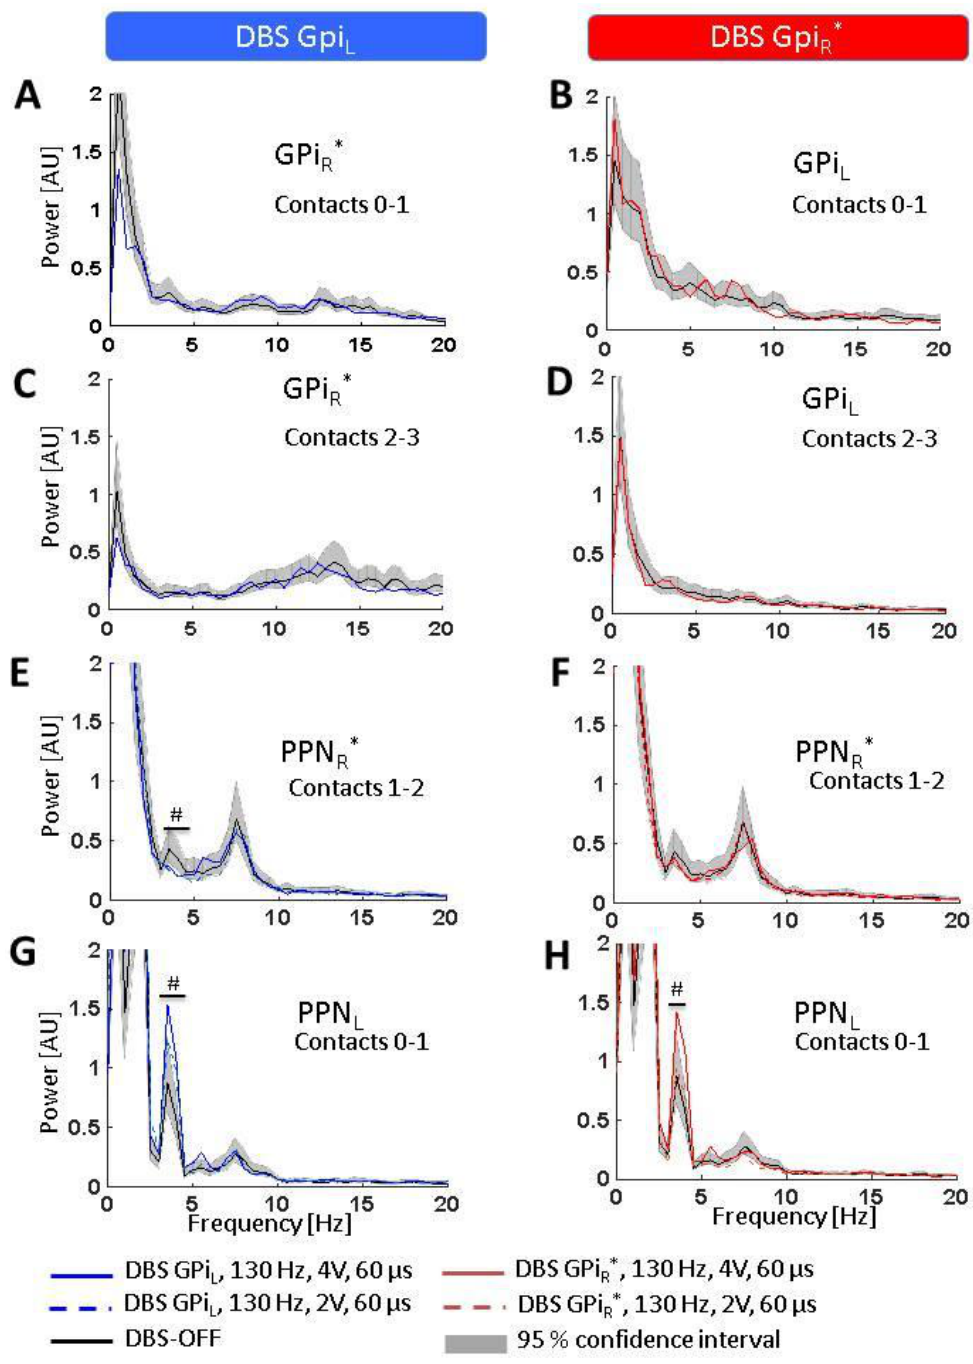
Figure 3. Effects of GPi-DBS on LFP spectra. Statistical significance levels of differences were derived by comparing the DBS on-spectra to the chi-square distribution assumed for the base line (DBS-OFF) spectra (see Welch, 1967). Significant differences are marked by a ‘ # ’ indicating a significance level of p < 0.05. ( A – D ) No spectral changes were observed in GPi R * or GPi L (neither at contacts 0–1 nor 2–3) during DBS of the contralateral GPi; ( E , F ) A slight but significant decrease was observed in the lower theta band in PPN R * during GPI L -DBS but no spectral change was observed in PPN R * during GPi R *-DBS; ( G , H ) DBS of either GPi L (left) or GPi R * (right) led to increased activity in the lower theta band in PPN L . Abbreviations: DBS: deep brain stimulation, GPi: globus pallidus internus ( L = left, R = right, * denotes clinically more affected side), LFP: local field potentials, PPN: pedunculopontine nucleus region ( L = left, R = right, * denotes clinically more affected side).